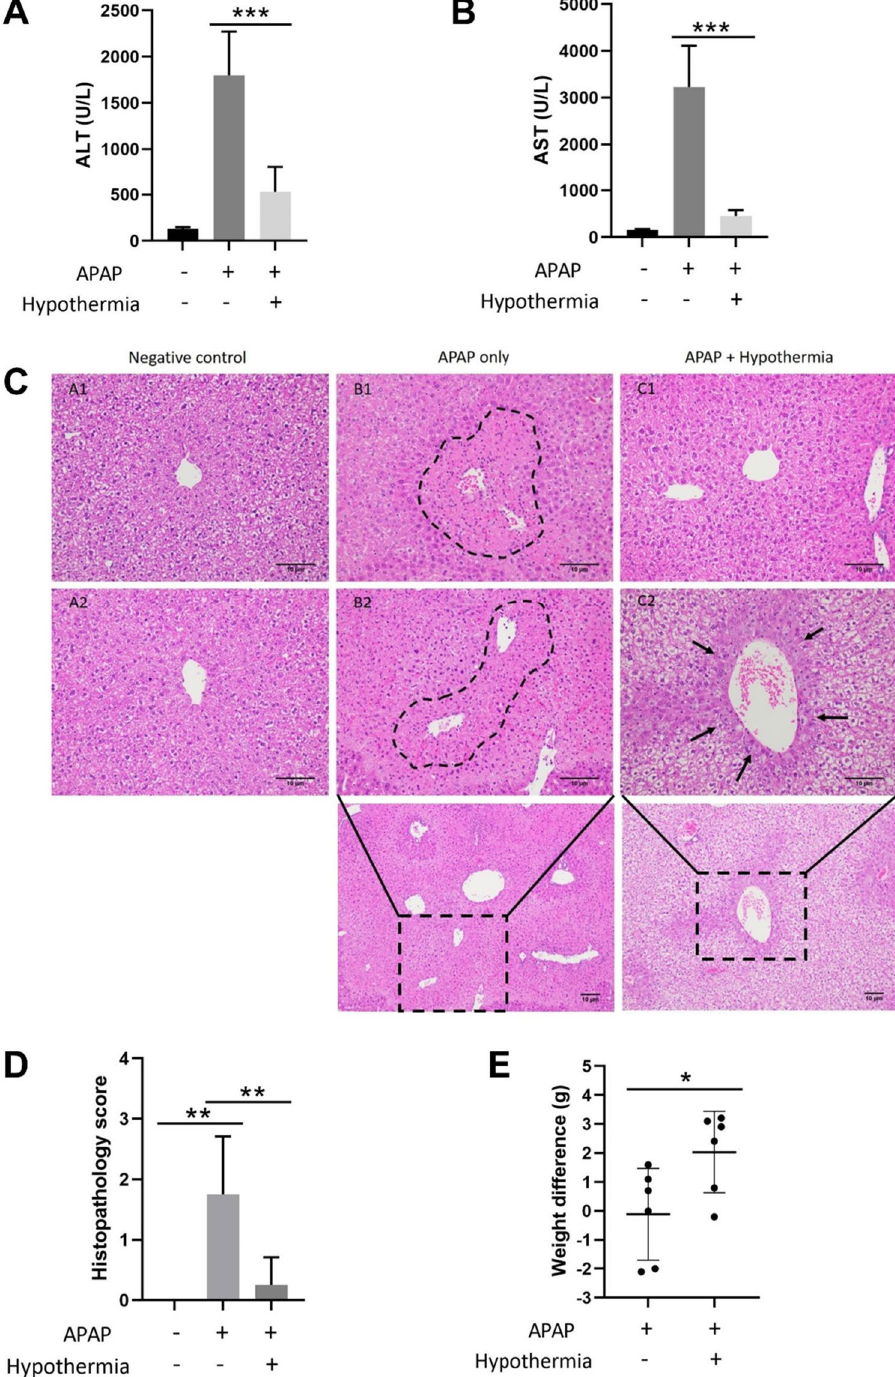
Figure 4. Effect of pulsed cooling on AILI and the overall well-being of mice. Quantitative analysis of ( A ) ALT and ( B ) AST levels were evaluated along with qualitative analysis of liver damage based on ( C ) liver histology using H&E staining. Liver histology in two representative mice in each treatment group is shown. Mice without APAP treatment and without pulsed cooling displayed unremarkable liver histology in both left (A1) and right (A2) liver lobes; mice administered with 300 mg/ kg APAP displayed (B1) centrilobular necrosis (left lobe) and (B2) bridging coagulative necrosis between centrilobular zones (right lobe) while mice administered with 300 mg/kg APAP and concomitant pulsed cooling displayed (C1) unremarkable liver histology (left lobe) or (C2) some loss of glycogen (right lobe). ( D ) Histopathological scoring of the degree of liver cell damage was also performed for all mice samples. Finally, mice were weighed before and after 24 h of APAP administration. ( E ) The weight difference was compared between treatment groups, with or without pulsed cooling, as an indicator of the overall well-being of the mice during AILI. Data are presented as mean ± SD (n ≥ 3) where one-way ANOVA was used to make comparison amongst treatment groups and post-hoc tests were subsequently carried out with correction for multiple comparisons using the Sidak’s method. For comparison of weight difference between APAP-treated mice, with or without pulsed cooling, unpaired t-test was used instead. Scale bar = 10 µm. * P < 0.05; ** P < 0.01; *** P <